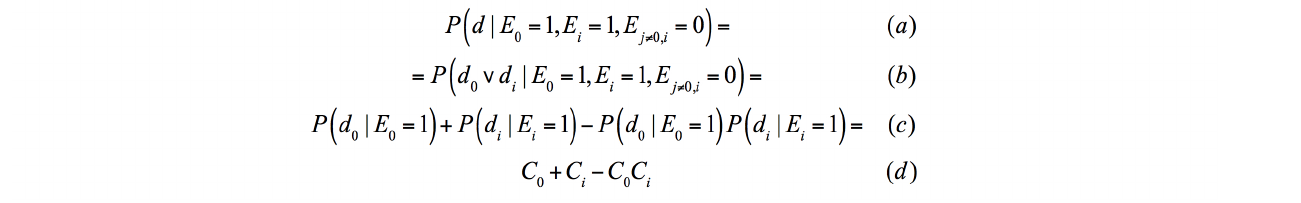
Figure 8. Probability to fall with exposure to exactly 1 risk factor.